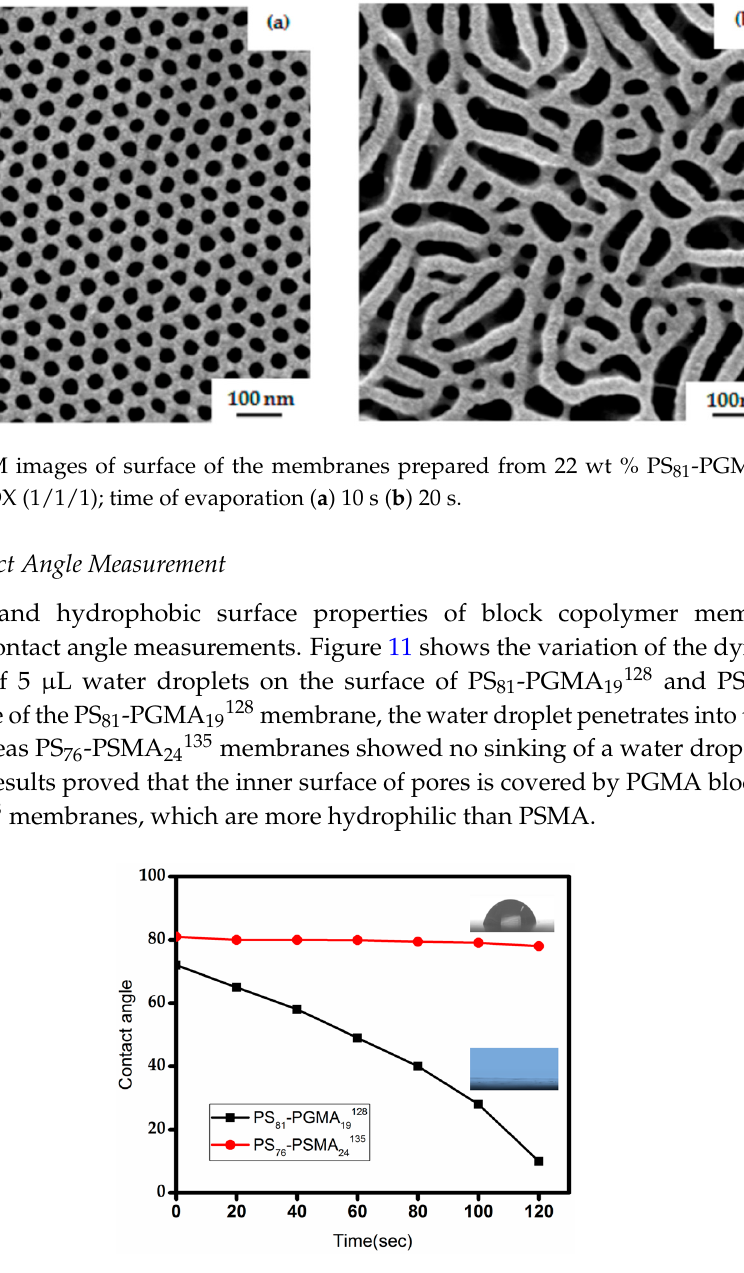
Figure 11. Graphical representation of dynamic contact angle measurement of water droplets (5 µL) onto membrane surfaces developed from block copolymers PS 76 -PSMA 24135 and PS 81 -PGMA 19128 (previously shown in Figure 9a,b).